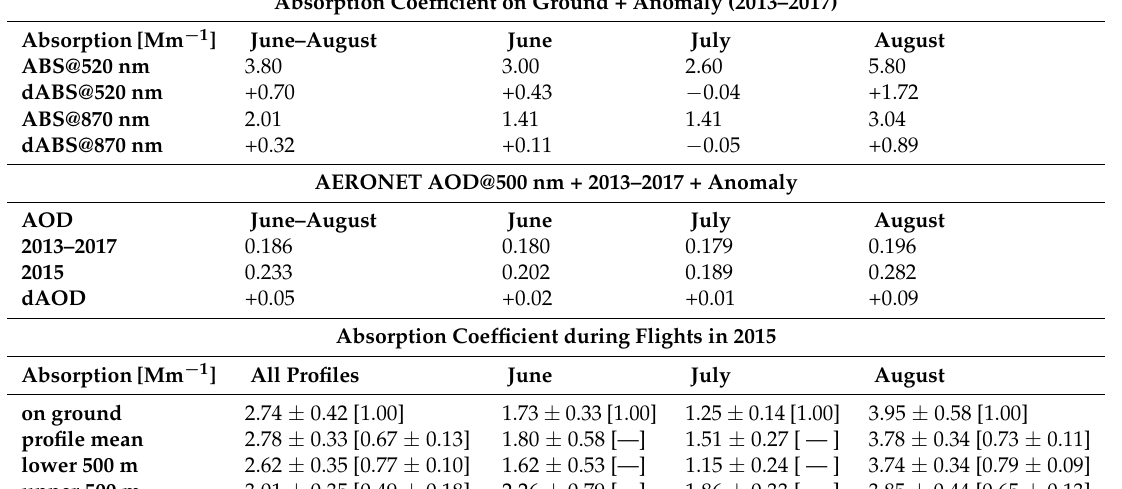
Table 2. Absorption coefficient measured on ground (AE-31), in profiles (AE-51 on unmanned aerial system (UAS)) and AOD during June–August 2015. For AOD and ground measurements monthly anomaly is calculated. Mean values for profiles are presented with confidence intervals and in brackets with Pearson correlation coefficient to ground